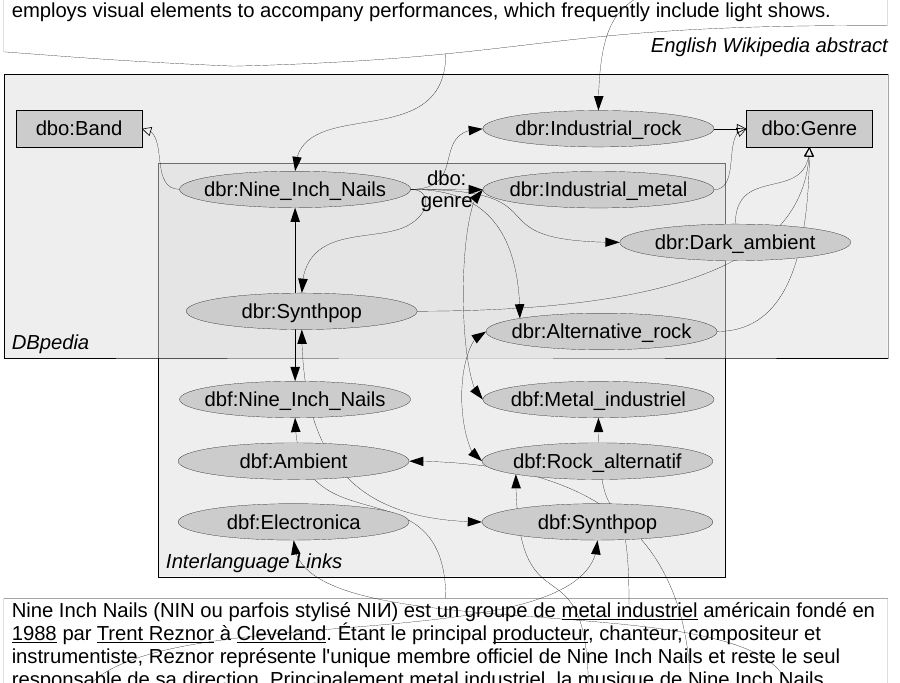
Figure 2. Approach illustrated with extraction from English ( above ) and French ( below ) Wikipedia